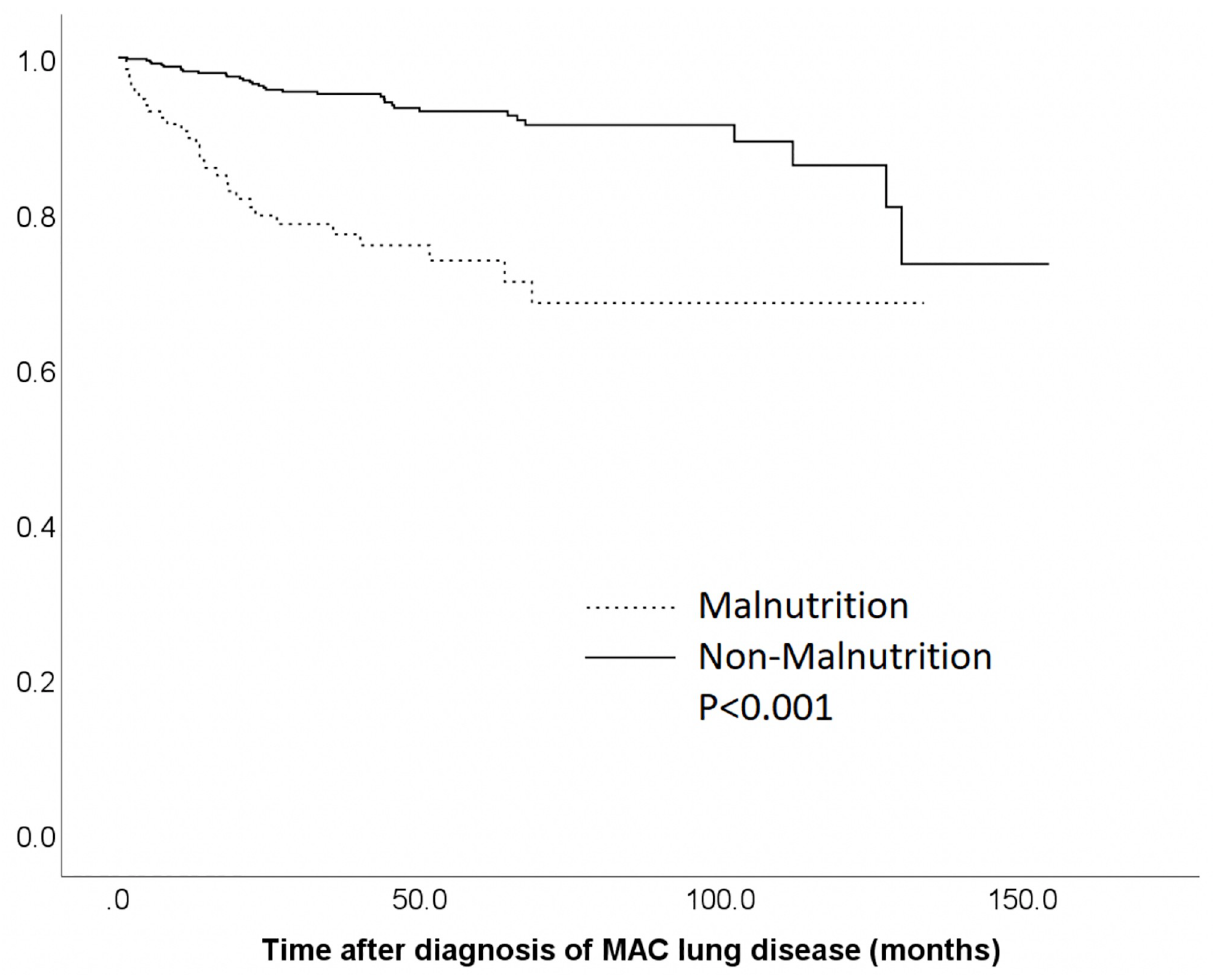
Fig 2. Kaplan–Meier survival curves stratified by nutritional status. Patients were divided into malnutrition and non-malnutrition groups according to prognostic nutritional index � . � Cut-off value of prognostic nutritional index for defining malnutrition and non-malnutrition was 45. List of Abbreviations; MAC, Mycobacterium avium